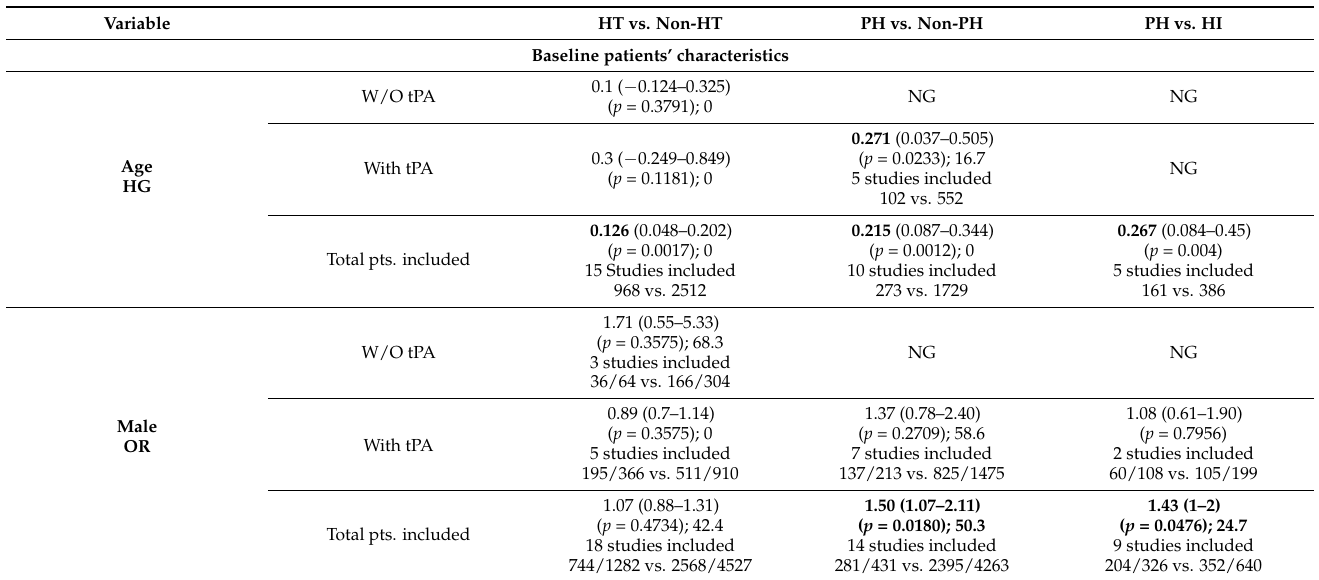
Table 2. Patient Group Differences based on risk factors; effect size (95% CI); heterogeneity magni- tude